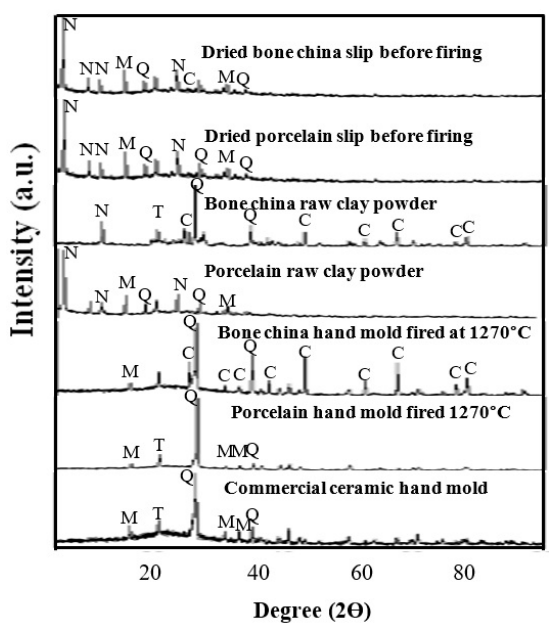
Figure 6: XRD peak patterns of porcelain and bone china hand molds before and after firing at 1270 ∘ C (M-mullite, Q-SiO 2 -quartz, T-calcium phosphate, C-Al 2 O 3 -alumina-corundum, N-sodium alu- minium silicate